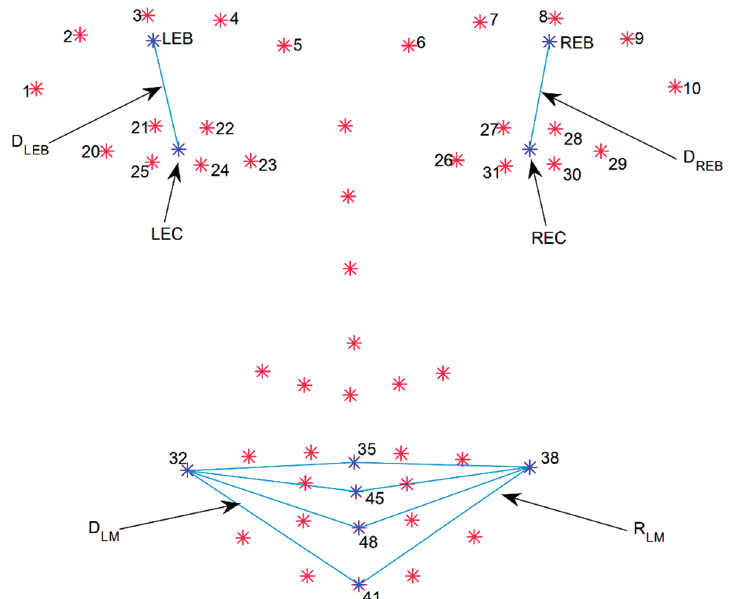
Figure 3. Descriptions of parameters used to calculate asymmetric indices. LEB represents a mean point of left eye brow and REB represents mean point of right eye brow. LEC represents a mean point of left eye and REC represents mean point of right eye. (cid:1830) (cid:3013)(cid:3006)(cid:3003) indicates distance between LEB and LEC. (cid:1830) indicates distance between REB and REC. (cid:3019)(cid:3006)(cid:3003) represents left mouth corner and P represents right mouth corner. (cid:1830) and (cid:1830) P (cid:2871)(cid:2870) (cid:2871)(cid:2876) (cid:3013)(cid:3014) (cid:3019)(cid:3014) indicate mean distance between point of mouth corner ( P , P ) and points of middle of (cid:2871)(cid:2870) (cid:2871)(cid:2876) mouth ( P , P , P , P (cid:2871)(cid:2873) (cid:2872)(cid:2869) (cid:2872)(cid:2873) (cid:2872)(cid:2876)